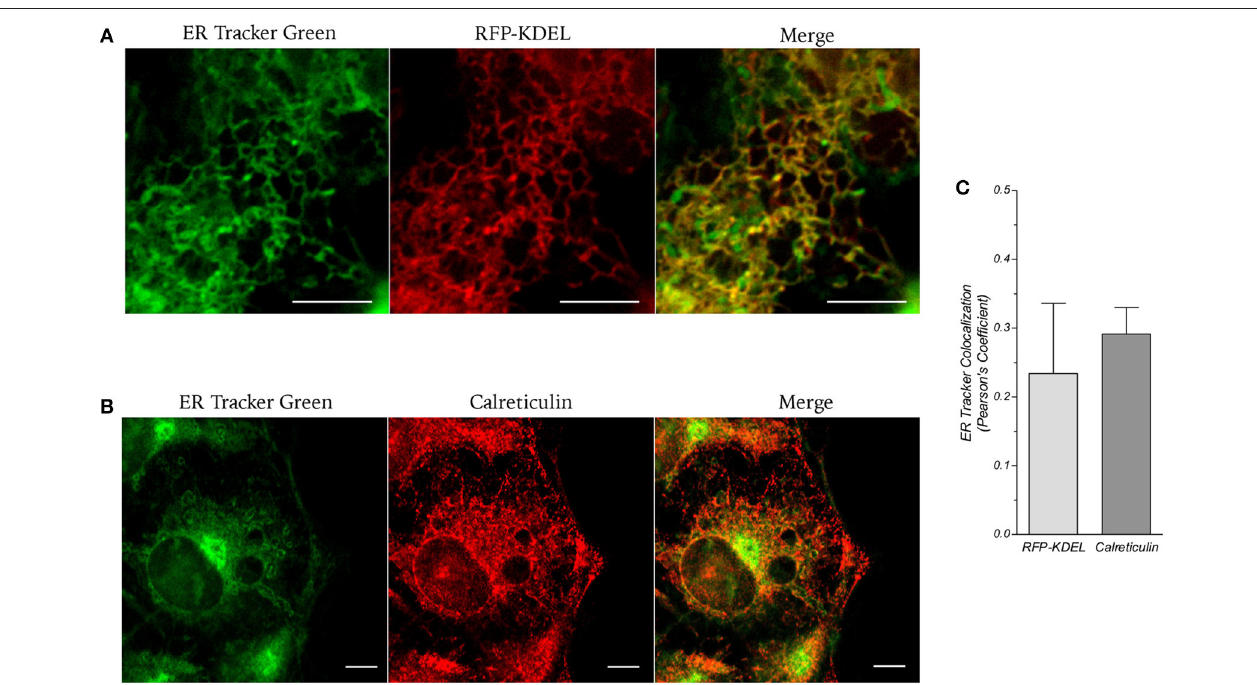
FIGURE 3 | (A) Live cell imaging of LX2 cells transfected with ER-reporter RFP-KDEL plasmid and subsequently stained with ER-Tr. (B) Immunostaining of LX2 cells for the endoplasmic reticulum marker calreticulin; cells were counter-labeled with NRB-AF12. Magnification 60x; scale bar 10 µ m. (C) Quantification of ER-Tr co-localization with RFP-KDEL and Calreticulin is shown as Pearson’s coefficient ( n ≥ 10).